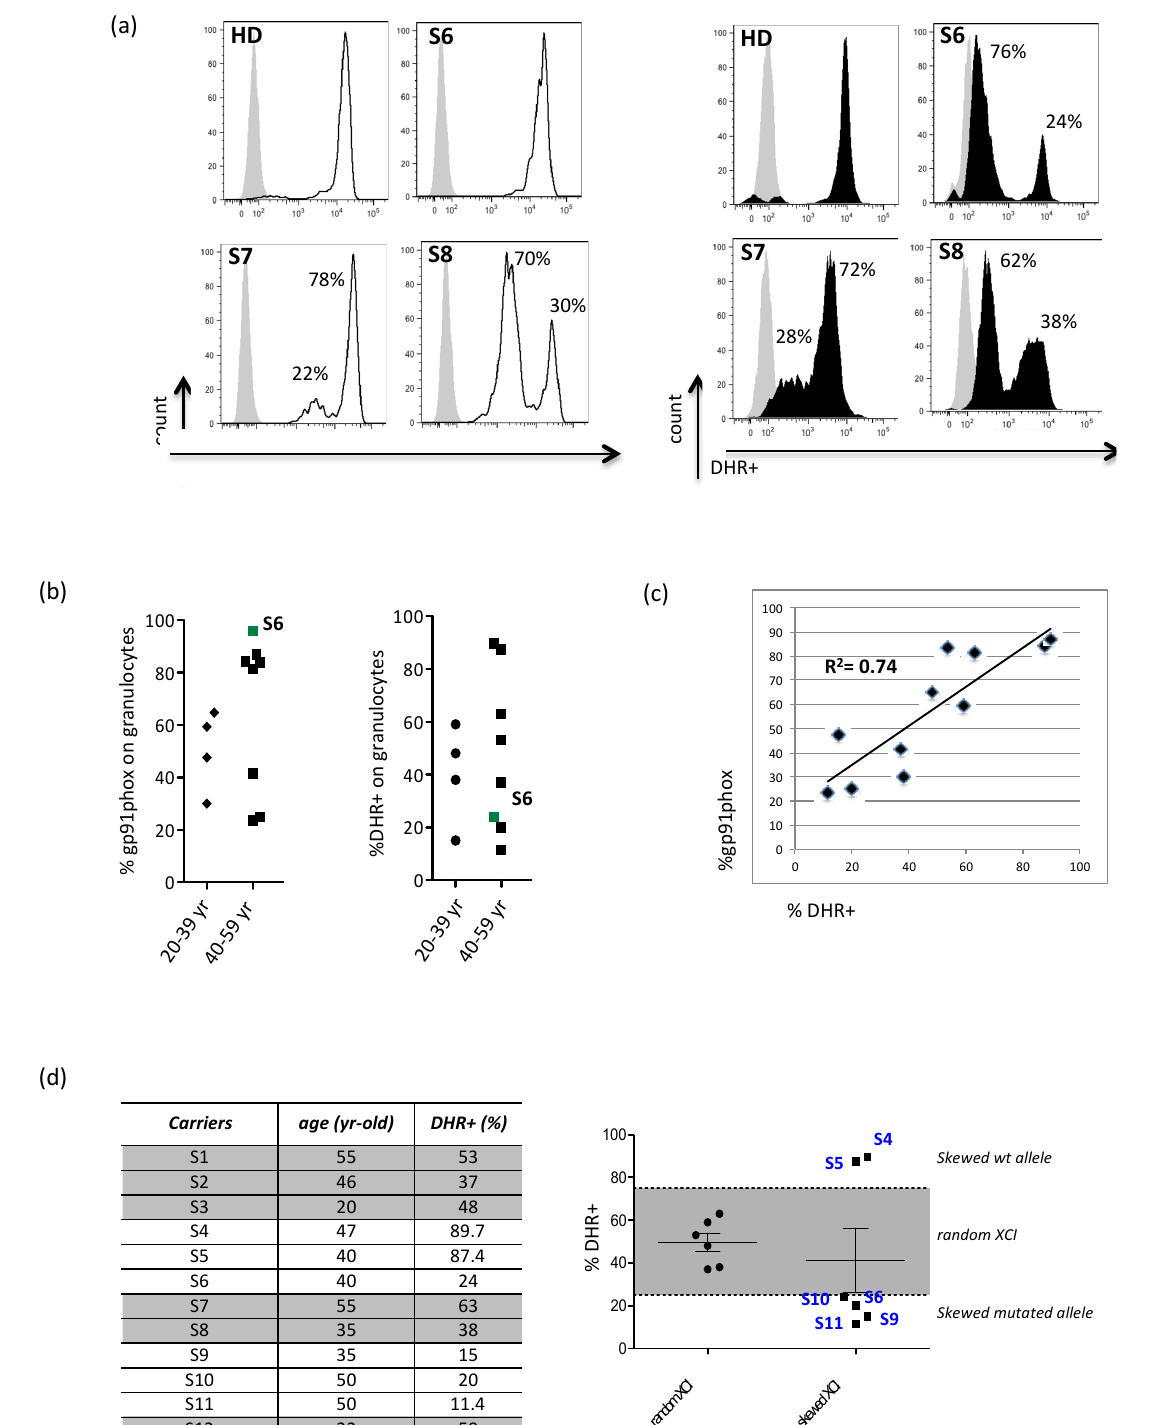
Figure 1. Evidence for X-chromosome inactivation age-independent in X-CGD carriers. ( a ) Representative FACS plots showing the gp91phox protein expression and NADPH oxidase function (DHR+) upon PMA stimulation of granulocytes from S6 (X91/X91+), S7 (X91/X91 ◦ ), S8 (X91/X91 ◦ ) carriers; ( b ) graphs showing the % of gp91phox protein and DHR+ cells evaluated in all carriers stratified by age. Each point shows a single X-CGD subject. The indicated S6 carrier is the only one with an X91/X91+ protein profile; ( c ) Correlation profile ( R 2 = 0.74) estimated between the % of gp91phox protein and the % of DHR+ value in carriers with X91/X91 (Spearman rank correlation test); ( d ) left panel shows the % of DHR+ evaluated by age. On the right, each point shows a single female subject; the grey zone indicates the random-XCI (from 25% to 75%), and the white external area indicates skewed XCI (wt gene: S4, S5; mutated gene: S6, S9, S10,